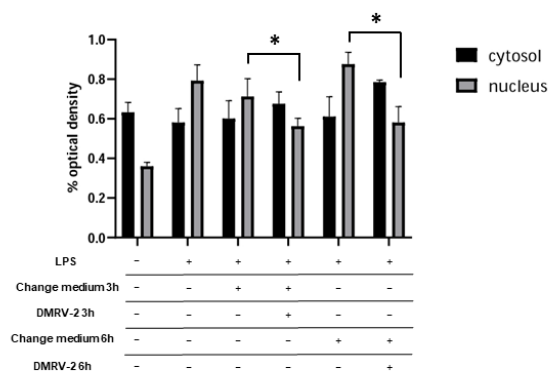
Figure 5. NF- κ B translocation analysis. HUVECs were stimulated with 0.1 µ g/mL LPS for 4 h and then incubated with DMVR-2 or underwent change of the medium. A WB-based measurement of the NF- κ B concentration in the HUVEC cytosol or nucleus following the different treatments was performed. The results of densitometric analysis of the resulting bands, normalized towards the suitable control (nucleolin for nucleus and GAPDH for cytosol) are reported. * p < 0.05 vs. respective controls.